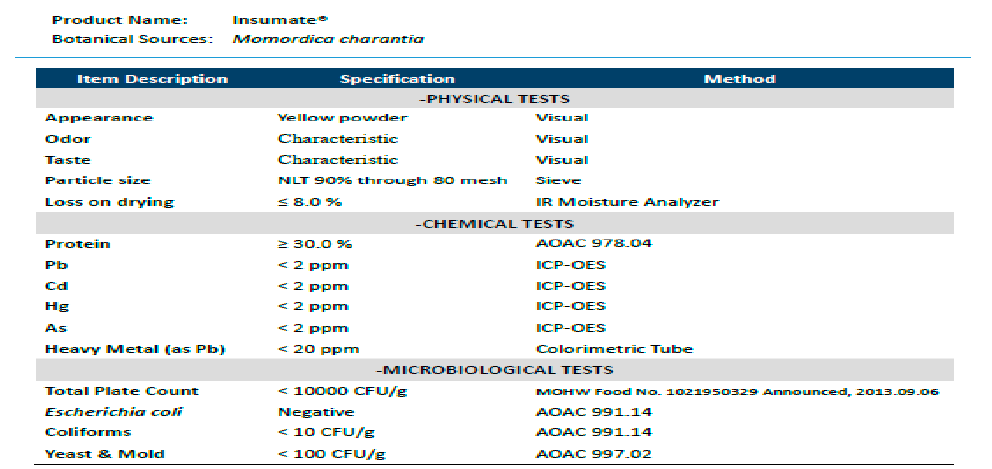
Table A1. Nutritional facts of BMP.